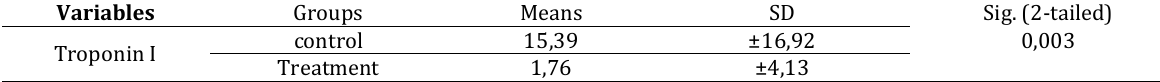
Table 3. Troponin I in the Coronary Heart Disease clients after being given self affirmation Variables